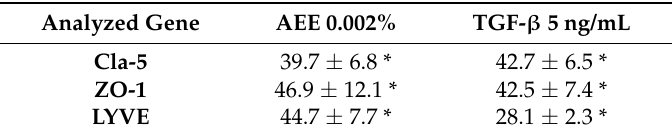
Figure 3. Protection against oxidative stress. The amount of ROS production was measured in HDLEC treated with 0.002% of AEE (% of Artichoke Ethanolic Extract powder used in the assay, w / v ), before and after oxidative stress induced by 450 µ M H 2 O 2 . α -Tocopherol was used as positive control in the assay. All determinations were conducted in triplicate and the results are expressed as mean ± SD. * p < 0.05 compared to stressed control, set as 100%. Table 3. Effects of AEE on tight junction proteins in lymphatic endothelial cells. The gene expression levels of Cla-5, ZO-1 and LYVE were measured in HDLEC incubated with two different concentrations of AEE (% of extract powder used in the assay, weight/volume) or TGF- β (5 ng/mL), used as positive control. The measures reported indicate the increases of gene expression level (expressed as %) of the treated samples compared to the untreated controls.